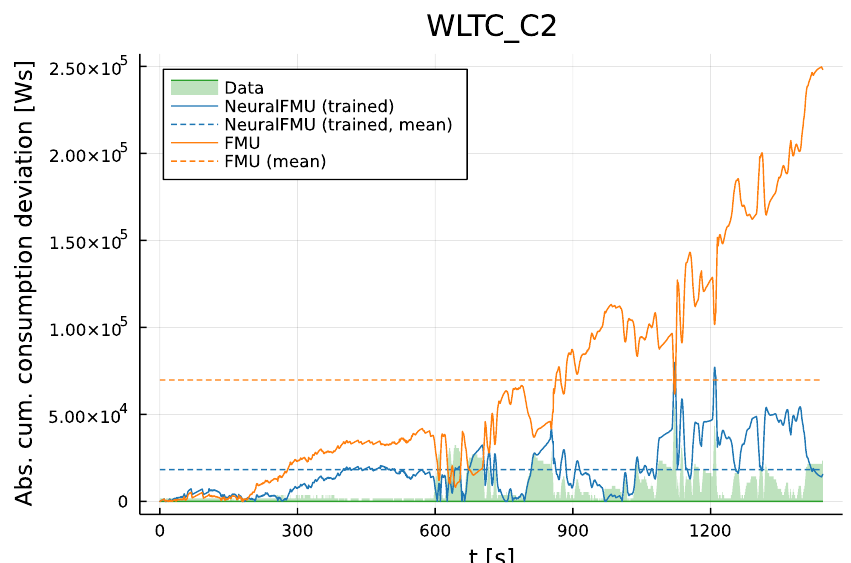
Figure 15. Absolute error of the consumption prediction of the NeuralFMU (blue) compared to the original FPM/FMU (orange). The unknown WLTC Class 2 is used for testing. Even if the NeuralFMU solution (blue) does not always lie inside the data uncertainty region (green), it leads to a much better prediction than the original FPM, which, in contrast, almost completely misses the data uncertainty area (green, translucent).